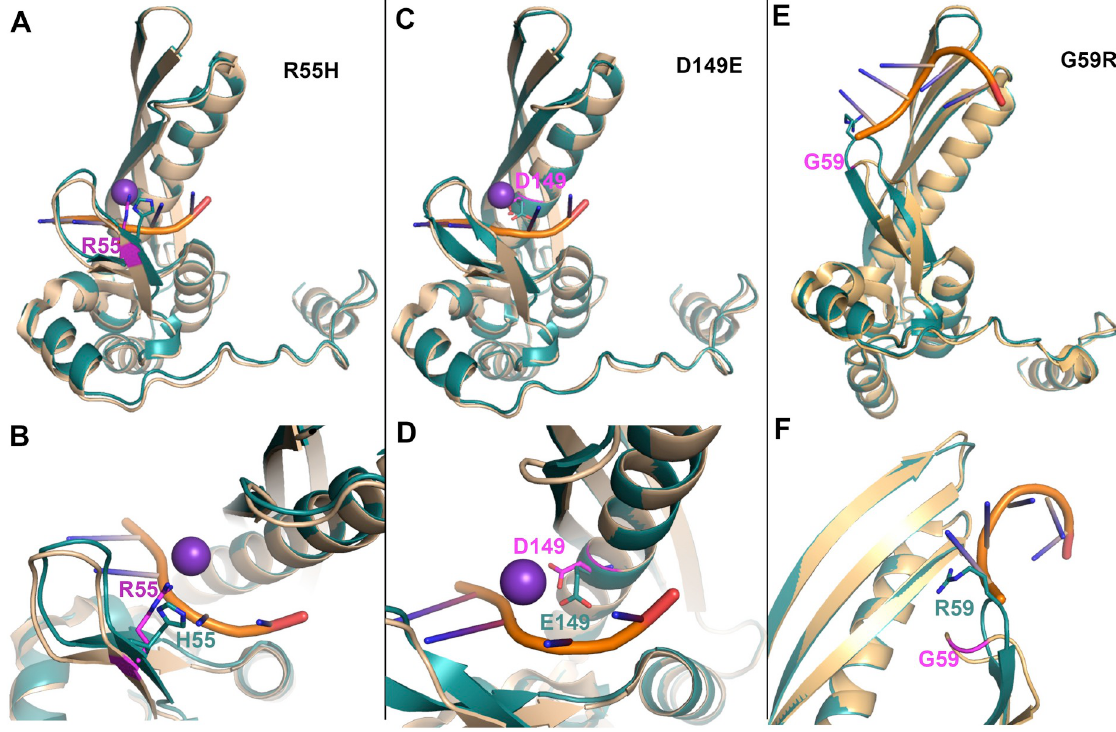
Fig 5. The effect of R55H, D149E, and G59R on the structure of RAD52. Structures of point mutations (cyan) were generated using homology modeling and then aligned to known structures of RAD52 (tan). The side chain of the mutated residue is shown in sticks. A . R55H mutant is aligned to a monomer with DNA bound to the inner site (PDB ID: 5XRZ). B. Zoomed in view of the R55H mutation compared to wildtype. C . D149E mutant is aligned to a monomer with DNA bound to the inner site (PDB ID: 5XRZ). D. Zoomed in view of the D149E mutation compared to wildtype. E . G59R mutant is aligned to a monomer with DNA bound to the outer site (PDB ID: 5XS0). F. Zoomed in view of the G59R mutation compared to wildtype. (PDB ID: 5XRZ) and outer site (PDB ID: 5XS0) to determine if these residues were in contact with DNA or in the protein-protein interfaces of the oligomeric structure ( Fig 4A ) [71]. There are no full-length structures of RAD52 available since the C-terminal domain is flexible and interferes with crystallization. The R55 and D149 residues were observed to coordinate potas- sium ions that are critical for the binding of single-stranded DNA (ssDNA) in the inner site of RAD52 ( Fig 4B ). G48, M78, and A146 were not in contact with DNA, the potassium ions, or were located along the oligomerization interface. G125 is found along the oligomerization inter- face, however the residue is oriented so that any side chain would not point outwards. Struc- tures of single point mutants were then generated by making the corresponding change in the N-terminal sequence of RAD52 and then using homology modeling to build the structure of each mutant sequence using SWISS-MODEL [49]. Each mutant was aligned to known crystal structures of RAD52 to then determine how the mutation would impact protein structure, DNA binding, or oligomerization. The R55H mutation would be expected to negatively impact ssDNA binding within the inner site, as it helps anchor the phosphate backbone of DNA into the binding site and is near the potassium ion ( Fig 5A and 5B ). Modeling the D149E mutation shows that it could affect the coordination of the potassium ion as the longer side chain cannot be appropriately accommodated ( Fig 5C and 5D ). The other mutants (G48D, M78I, G125C, and A146V) did not show any significant impact on the protein structure ( S2 Fig ). A RAD52 G59R mutation identified in Black women with breast cancer was shown to have decreased